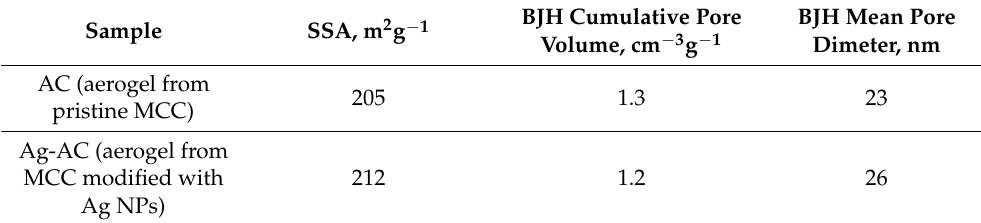
Figure 6. Nitrogen adsorption-desorption isotherms for cellulose-based aerogels: AC (black squares) and Ag-AC (red circles). Table 2. Textural characteristics of the cellulose aerogels.